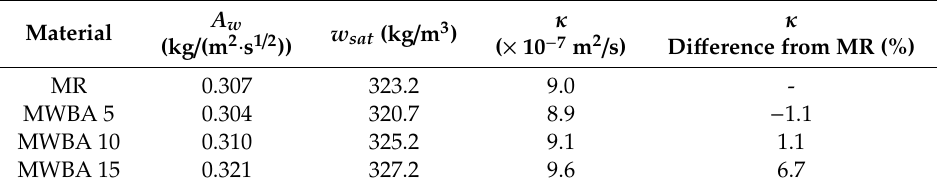
Table 11. Water transport parameters of studied mortars.